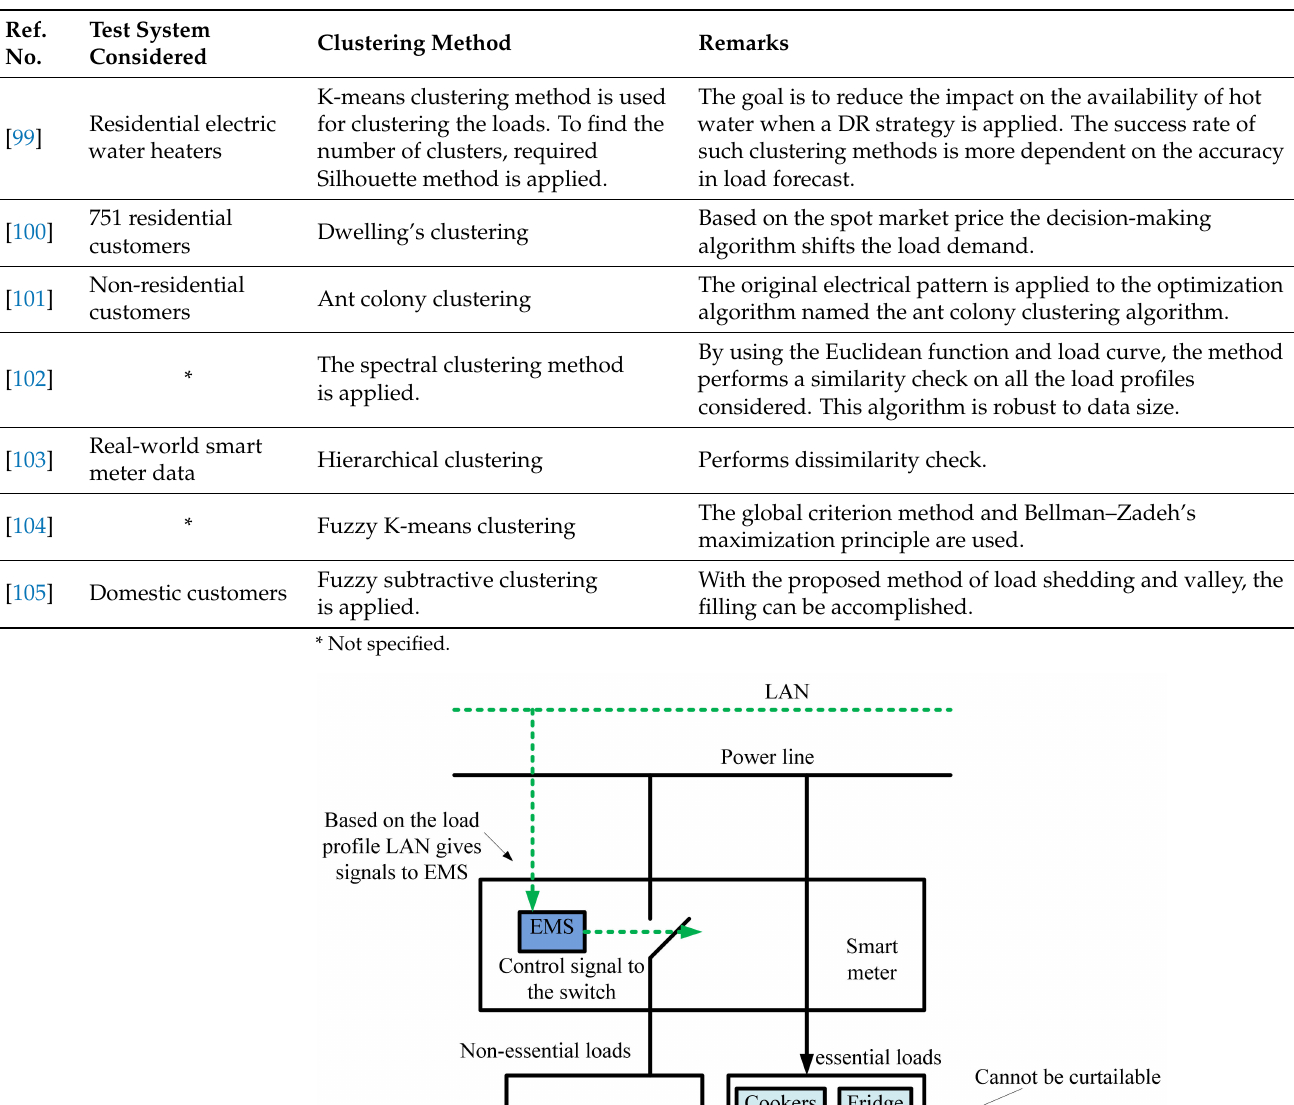
Table 7. A survey on various clustering methods.